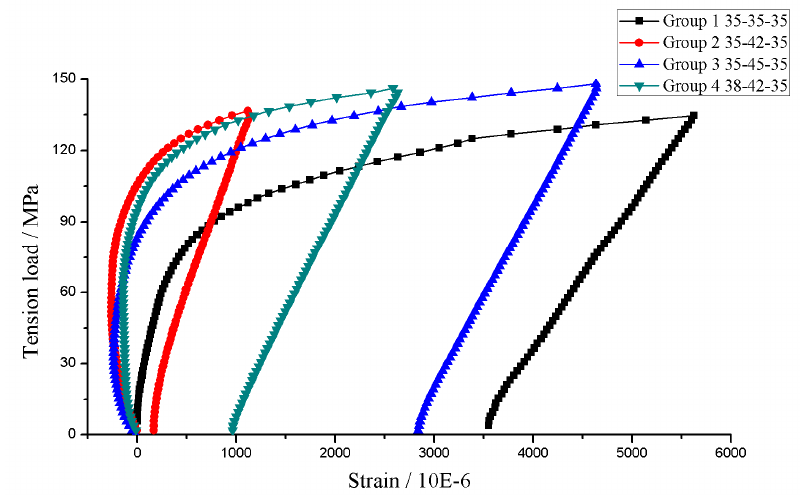
Figure 12. Strain value of Gauge 10.